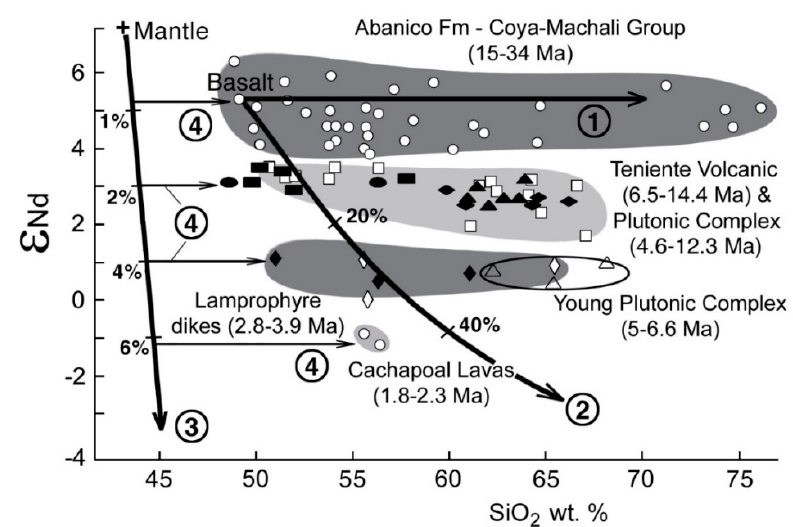
Figure 5. Published values of ε Nd vs SiO 2 (wt. %) for igneous rocks of different ages from the transect across the Andes at the latitude of El Teniente (34° S; open symbols including the Abanico Formation (o), Teniente Volcanic and Plutonic Complexes ( □ ), Young Plutonic Complex ( ∆ ) and lamprophyres ( ◊ ); [10,14,17,21–24]), compared with values for samples of the host-rocks in the deposit (filled symbols including the Teniente Mafic Complex ( (cid:4) ), Sewell Tonalite ( (cid:78) ), felsic porphyries( (cid:7) ), and Porphyry A granitoid ( ● ); [23]). Three curves illustrate the progressive changes in SiO 2 and ε Nd for crystal-liquid fractionation without assimilation, intra-crustal assimilation combined with crystal-liquid fractionation (MASH), and mantle source region contamination. Crystal-liquid fractionation increases SiO 2 without changing isotopic composition. MASH increases SiO 2 as ε Nd decreases. Source region contamination decreases ε Nd in the mantle, but mantle partial melting (curves ) for the modified mantle still produces mafic olivine-bearing basalts and lamprophyres. Tic marks along each curve indicate the same amount of crustal contamination as in the MASH and source region contamination models illustrated in Figure 4. Although the youngest felsic plutons in the deposit are the same age (4.6 to 7.1 Ma) as rocks from the regionally defined Young Plutonic Complex of small barren plutons outside the deposit (5 to 6.6 Ma; [10]), they are isotopically similar to the older host-rocks of the deposit as well as to the Teniente Volcanic and Plutonic Complex rocks. This is due to the fact that they formed above a large magma chamber within which mantle-derived magmas were mixed, stored and homogenized (but without crustal assimilation), so that the temporal isotopic changes in these mantle-derived magmas through time are not observed in the progressively younger felsic plutons within the deposit as a result of the large volume of the magma chamber into which these mantle-derived magmas mixed. In contrast, the small barren plutons of the Young Plutonic Complex outside the deposit do reflect these temporal changes in isotopic composition because they do not form above such a large magma chamber. (Reprinted from Geologic Society of American Bulletin, volume 117, Kay, S.M. et al., Episodic arc magmatism, crustal thickening, subduction erosion, and magmatism in the south-central Andes, page 80, Copyright 2005, with fair use permission from the Geologic Society of America.) .